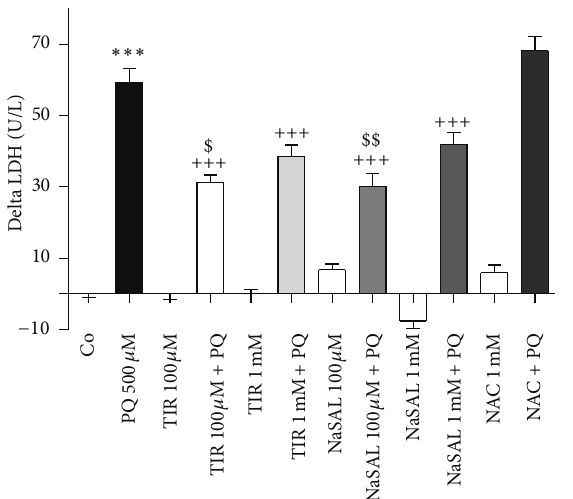
Figure 5: CHX, GBR 12909, and L-NAME decreased PQ-induced LDH release into the medium. Differentiated SH-SY5Y cells were pretreated with GBR 12909 (1 𝜇 M), CHX (1,8nM), and L-NAME (1 𝜇 M) 30 minutes prior to cultures exposure to PQ for 72 h. The delta increase in LDH release in units per liter (U/L) into the medium was calculated by subtraction of the respective controls (results were pooled from 3 different experiments, each experiment having 6 different culture wells per condition). The means were compared using one-way ANOVA, followed by Student-Newman- Keuls post hoc test ( ∗∗∗ 𝑃 < 0.001 PQ versus control; ++ 𝑃 < 0.01 , +++ 𝑃 < 0.001 PQ versus PQ plus